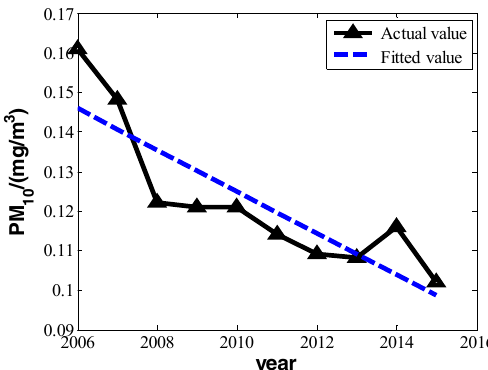
Figure 1. The change in the annual daily mean of inhalable particulate matter from 2006 to 2015.